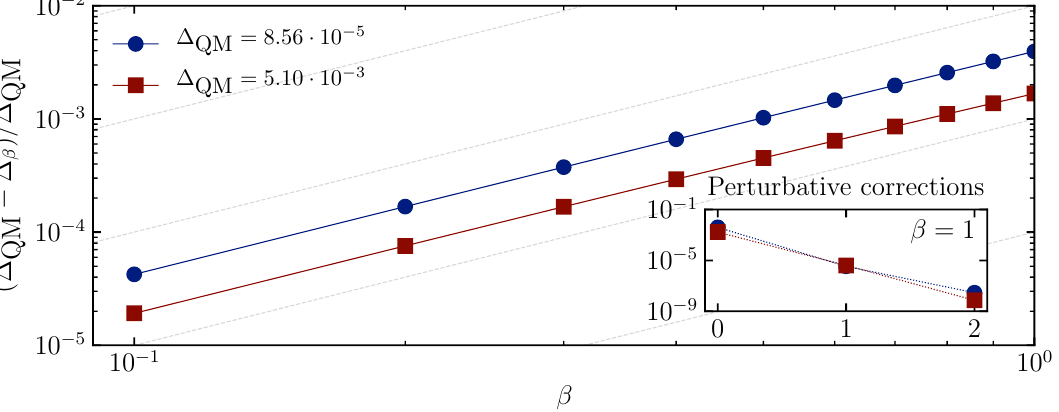
Figure 6: Relative difference of the classical energy level splitting in a double well potential with respect to the quantum level splitting for the Gibbs tempera- ture with varying β . The blue circles correspond to the two lowest tunneling states and the red squares correspond to the second pair of tunneling states. In both lines the relative difference scales approximately as β 2 (gray lines). The inset shows the relative difference at β = 1 for the level splittings in ˆ H ( 0 ) and ˆ H ( 1 ) and second-order ( 2 ) corrections in β as compared with those obtained from W . The parameters are the same as in Fig. 5.